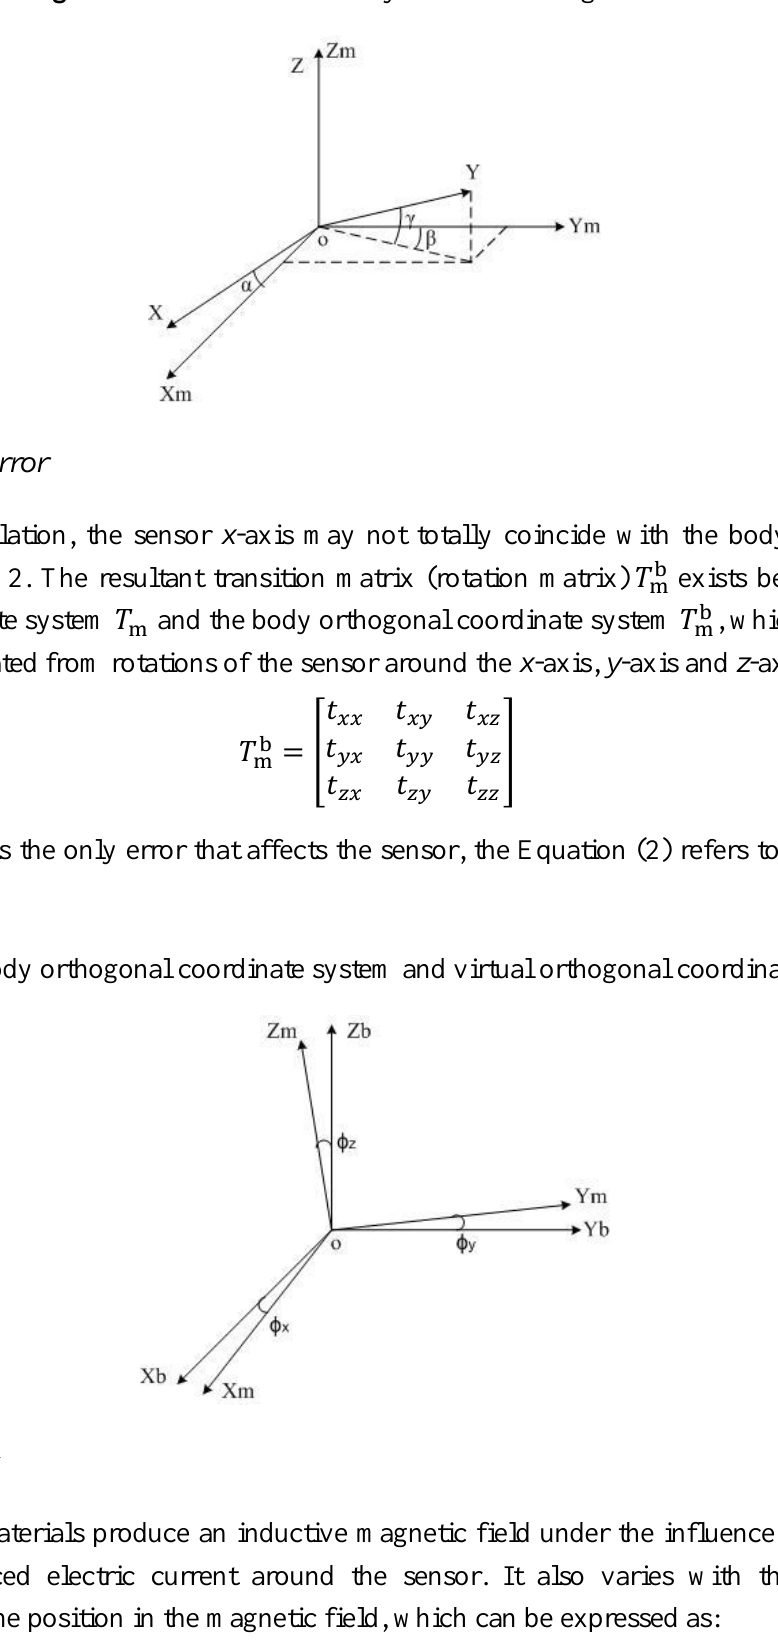
Figure 1. Sensor coordinate system non-orthogonal error.